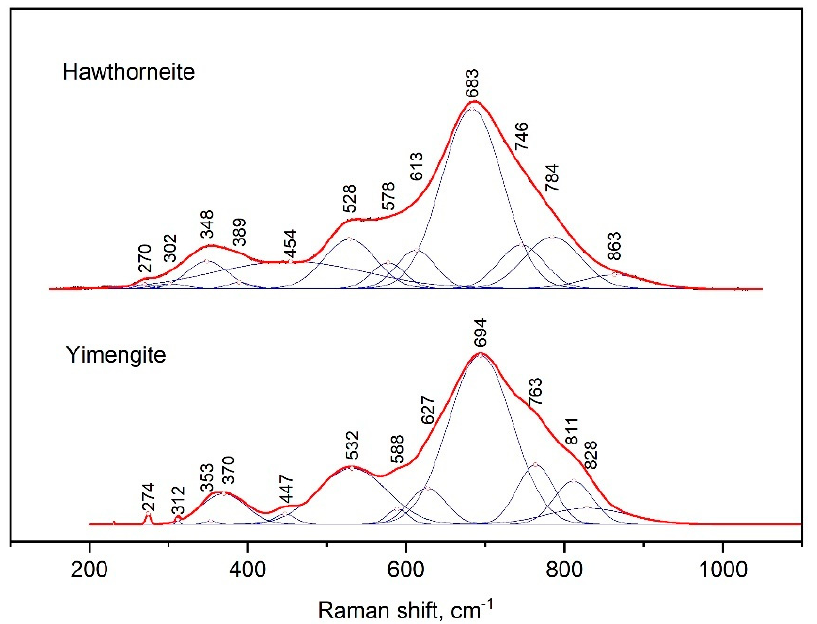
Figure 7. Raman spectrum of synthetic hawthorneite and yimengite, processed using the Fityk pro- gram.